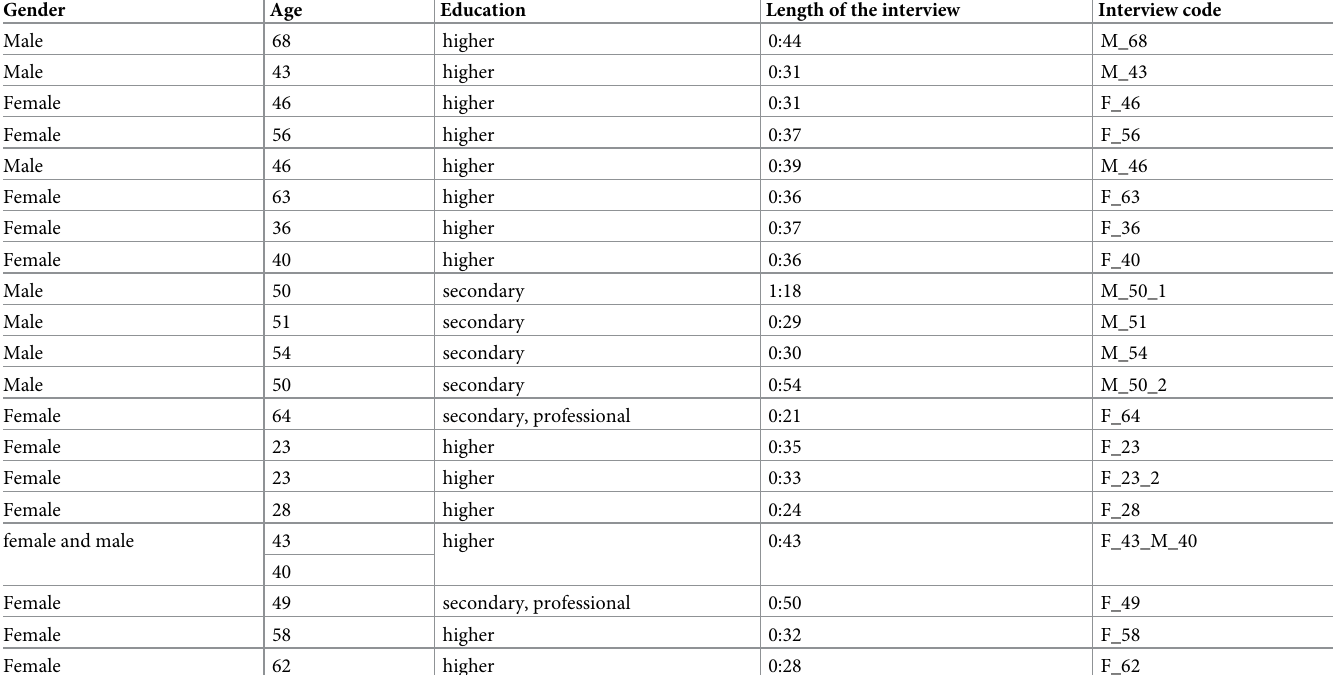
Table 1. Characteristics of donor interviewees and